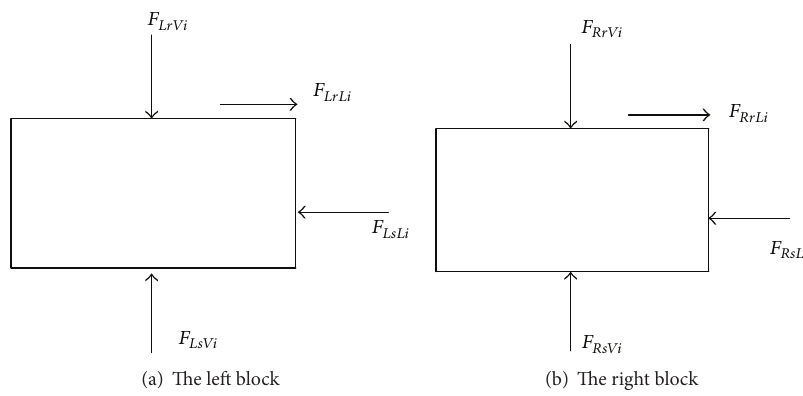
Figure 5: Forces of the left and right